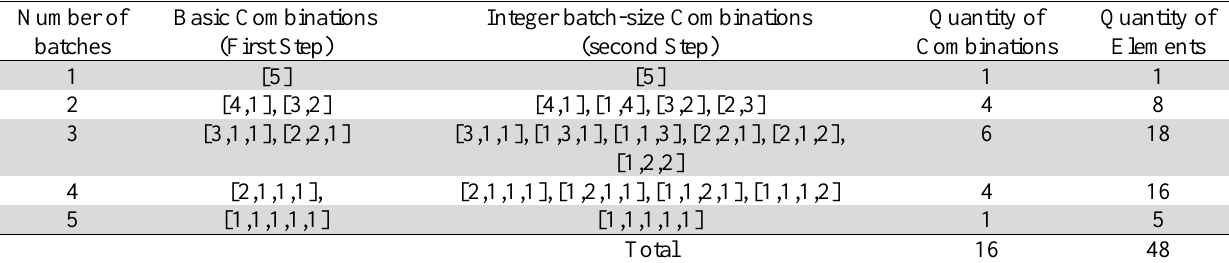
The Integer Composition Method Results